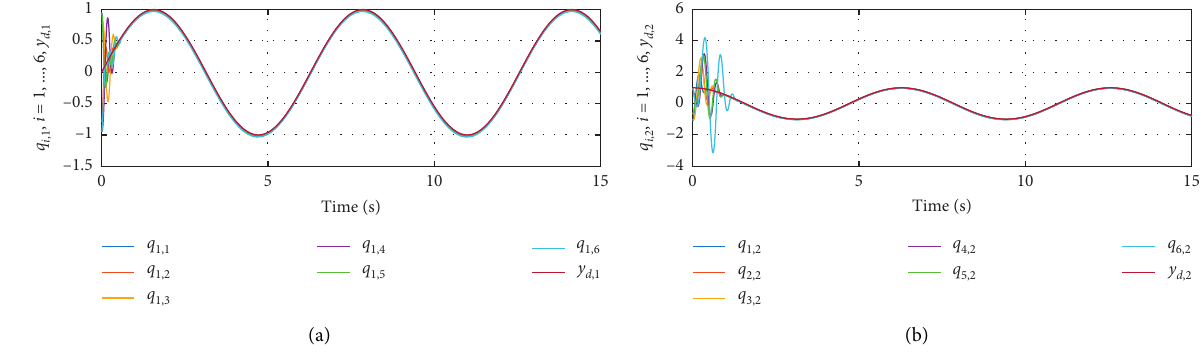
Figure 9: Response curves of q